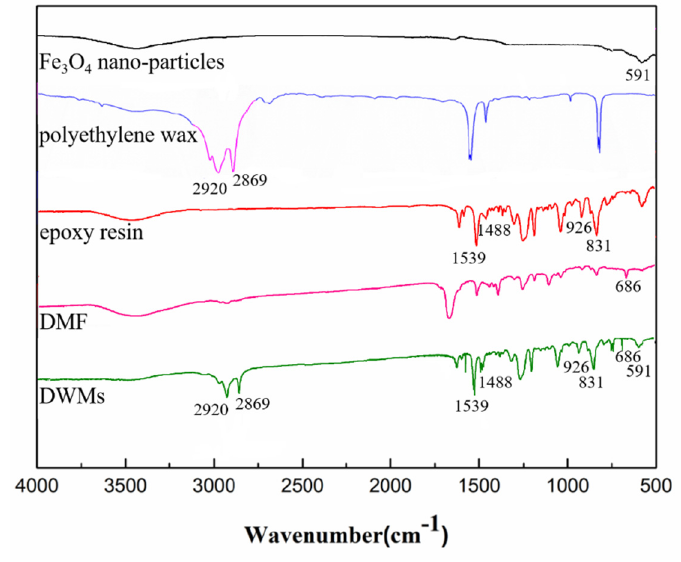
Figure 7. FTIR spectra of Fe 3 O 4 nano-particles, polyethylene wax, and epoxy resin, DMF and DWMs.